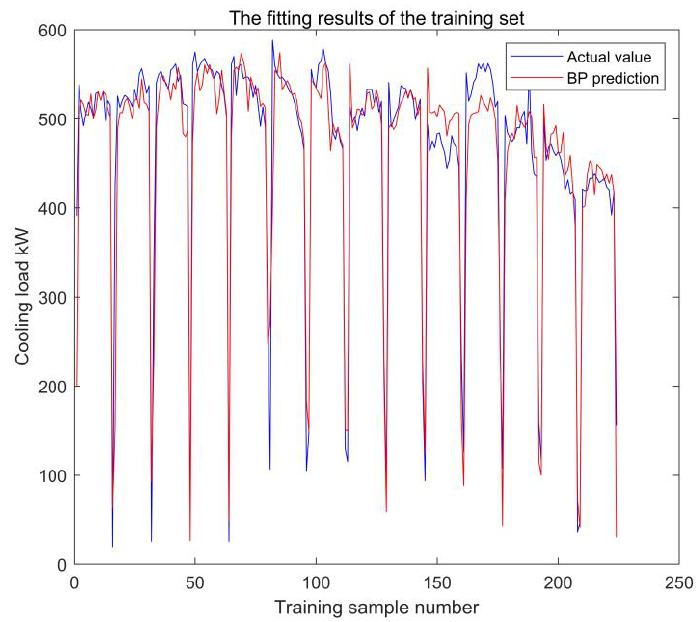
Figure 31. The fitting effect of the training set.